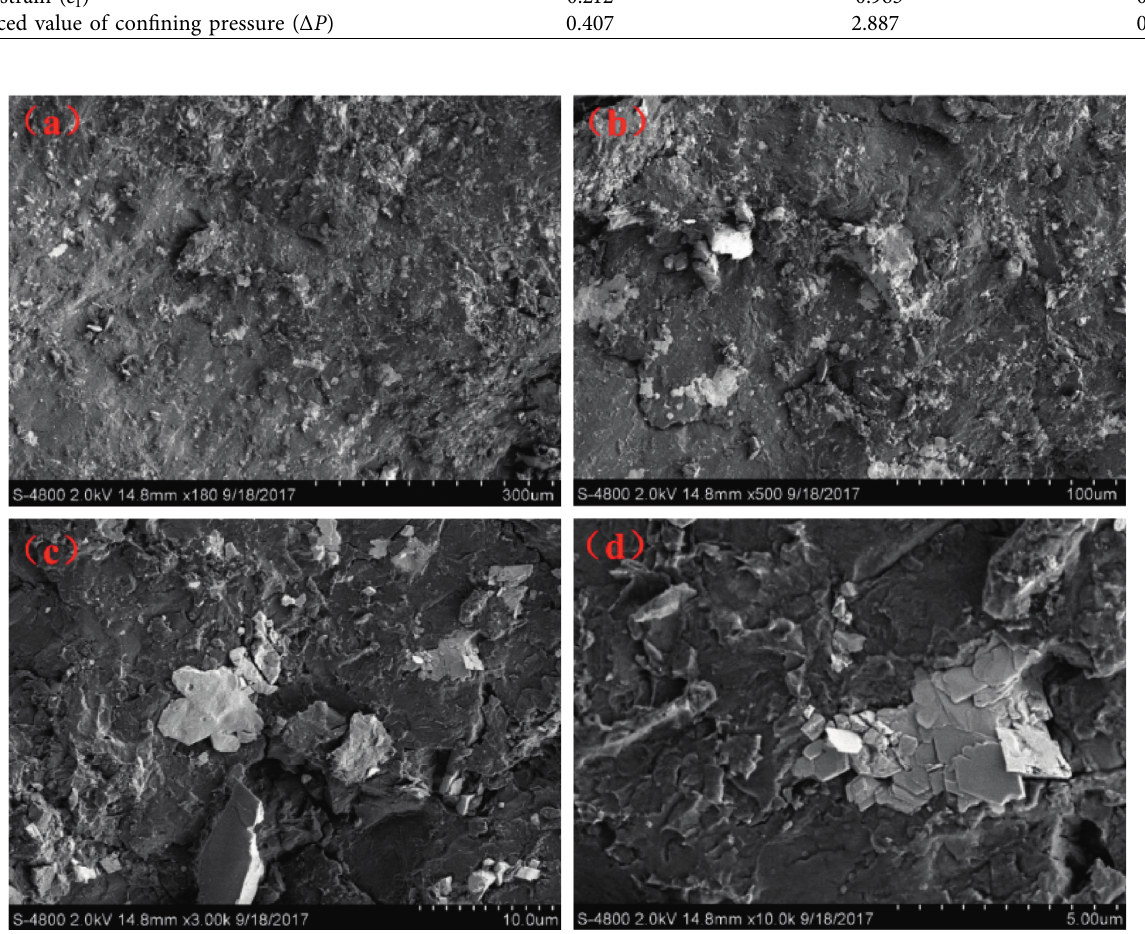
Figure 14: (a–d) SEM images with different magnifications of the coal